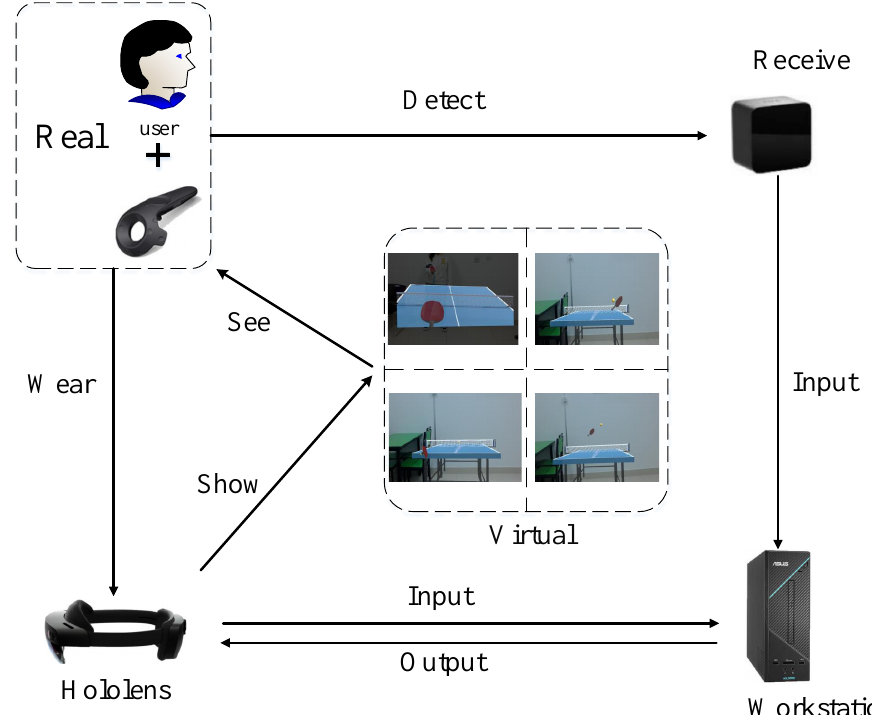
Figure 1. Interaction relationship between user and